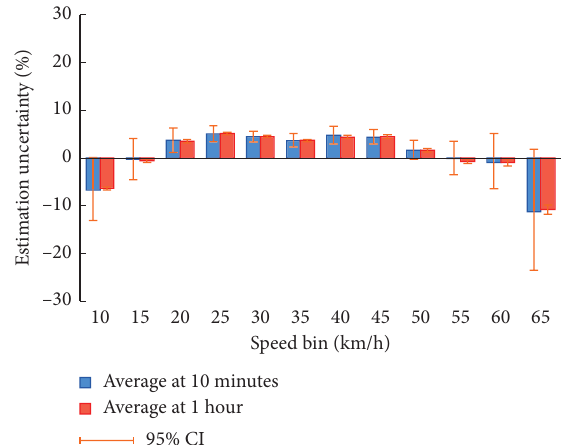
Figure 5: The characteristics of the estimation uncertainty based on data sets generated by